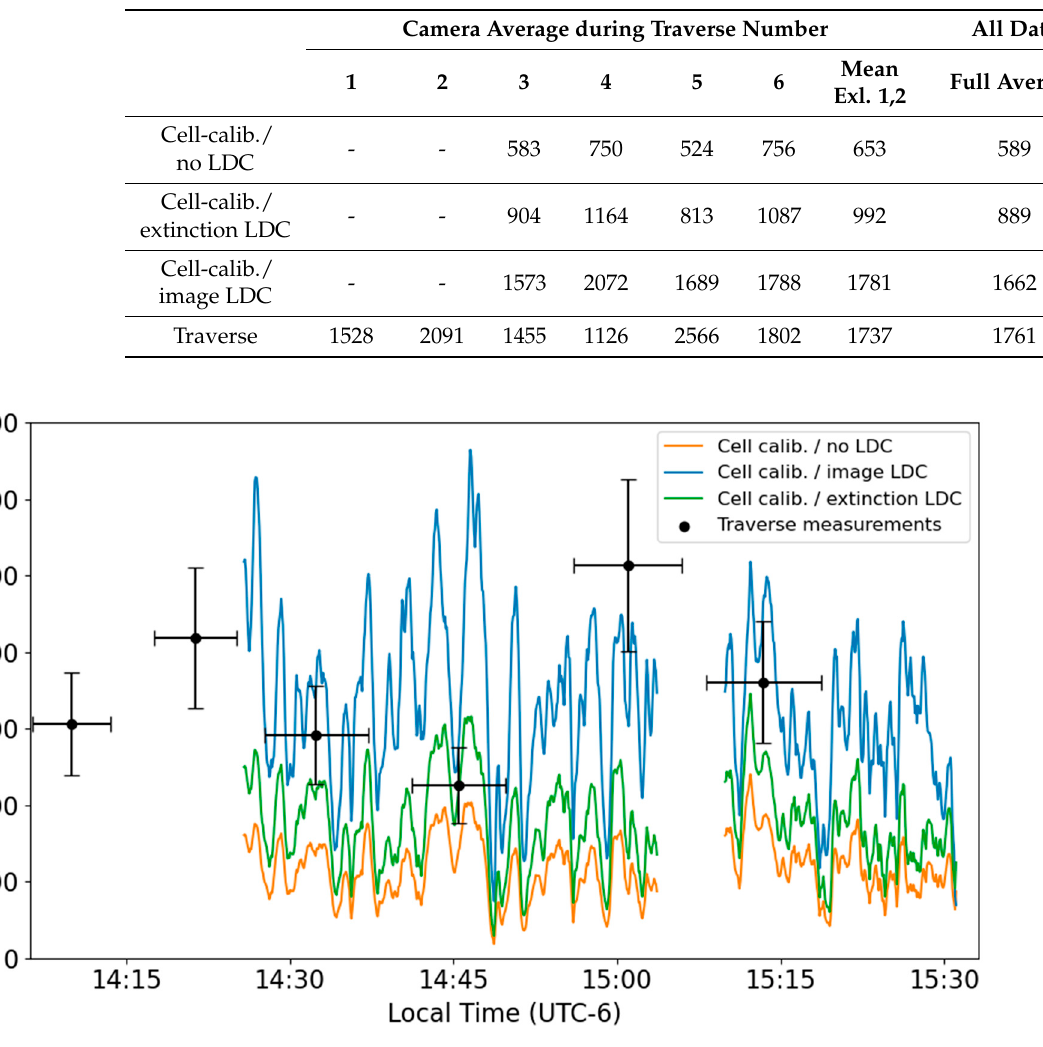
Figure 6. Uncorrected (orange), extinction (green) and image-based (blue) light dilution-corrected (LDC) SO 2 emission rate from 10 January 2018 as measured by the SO 2 camera. Simultaneous traverse emission rates, shown in black, are plotted at the time measured at the center of mass of the traverse minus the travel time from SO 2 camera measurement line to traverse road. The traverse error accounts for the duration of the traverse and the error in plume speed estimate from the camera.